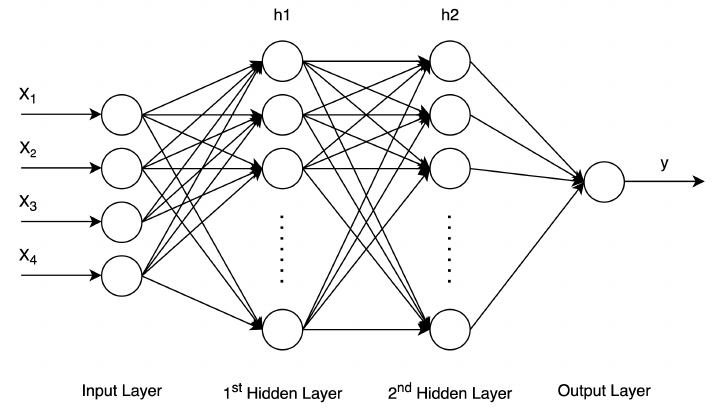
Figure 1. Proposed Neural Network.